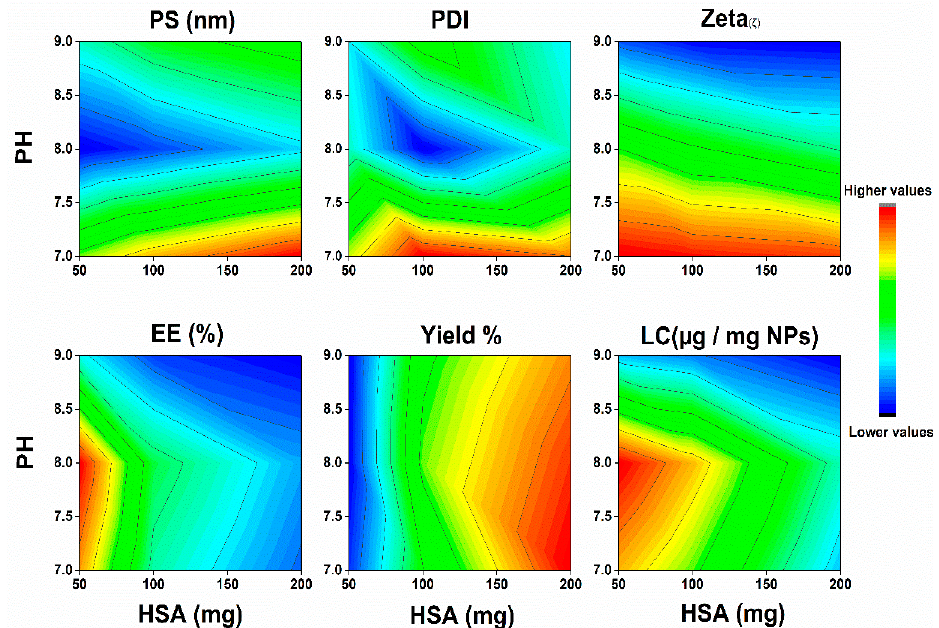
Figure 2. Contour plots generated by the D-optimal design demonstrating the effect of albumin concentration and aqueous medium pH using ethanol acetone as a desolvating agent on the albu- min nanoparticles diameter (PS), polydispersity index (PDI), Zeta potential, sesamol encapsulation efficiency (EE%), albumin nanoparticles percent yield, and sesamol loading in albumin nanoparti- cles (LC).